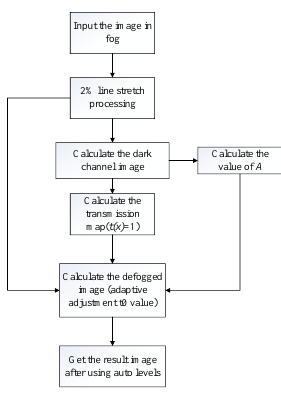
Figure 2. Flow chart of fog removal test for aerial